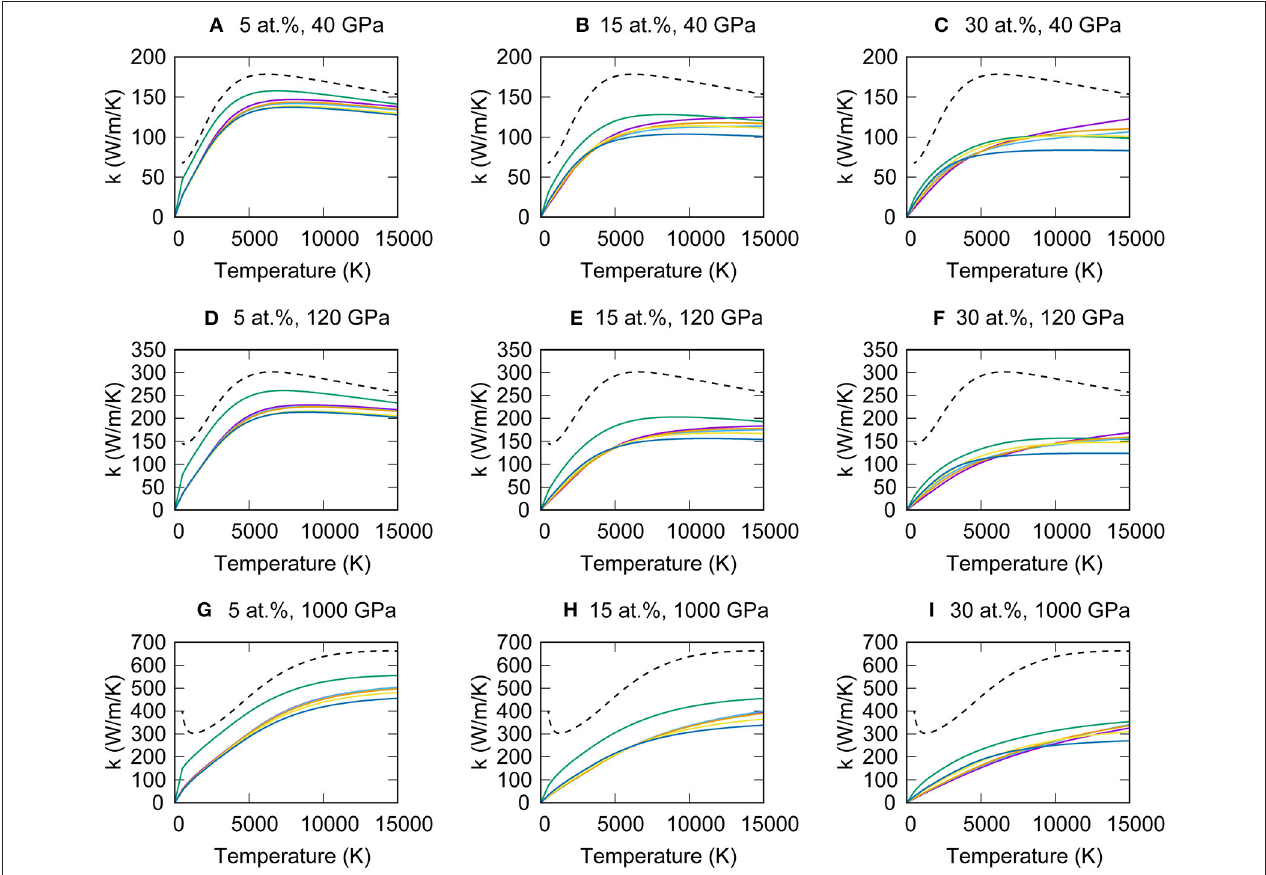
FIGURE 10 | Thermal conductivity of hcp Fe 0.95 X 0.05 , Fe 0.85 X 0.15 , and Fe 0.70 X 0.30 , where X is Si (purple), Ni (green), S (cyan), C (orange), N (yellow), and O (blue) at the volume of V = 19.10 Å 3 ( P ∼ 40 GPa at 300K) (A–C) , 16.27 Å 3 ( P ∼ 120 GPa at 300K) (D–F) , and 9.80 Å 3 ( P ∼ 1,000 GPa at 300K) (G–I) . Black broken lines are pure Fe for